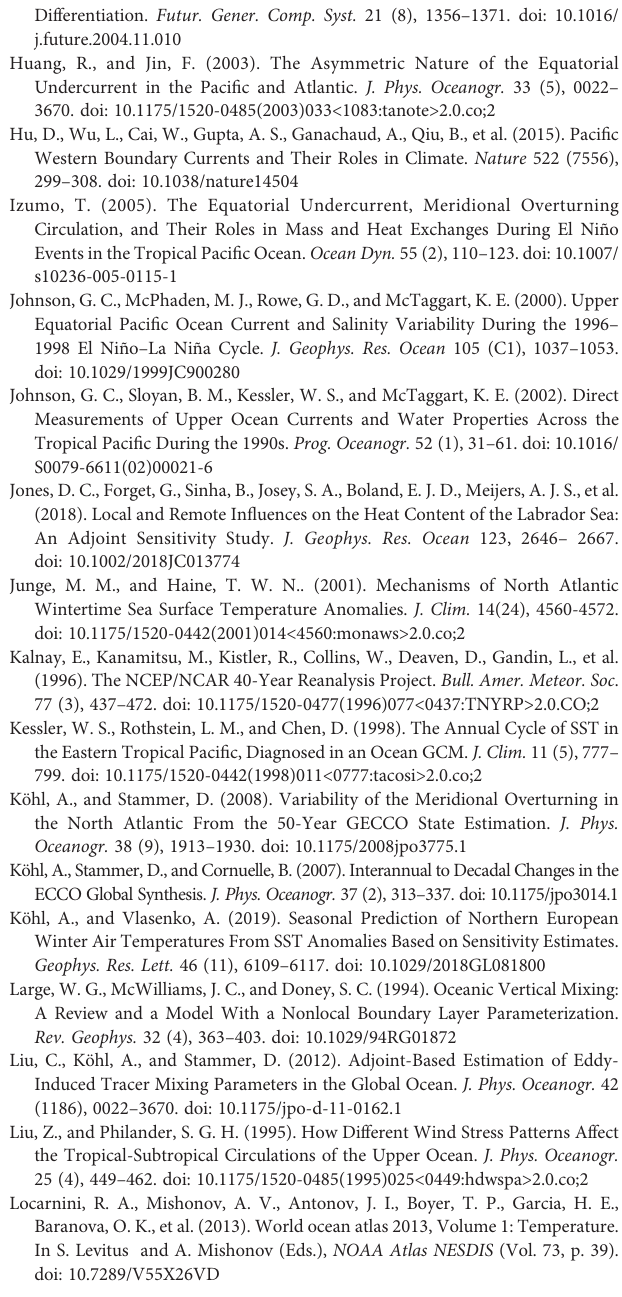
Supplementary Figure 4 | Adjoint sensitivity (Sv/Nm -2 ) of the EUCT at 142°E in July of the second year to monthly zonal wind stress from previous 11 to 1 months (marked as A – F , respectively) derived by GECCO. Supplementary Figure 5 | Same as Figure S4 , but derived from TOOSSE